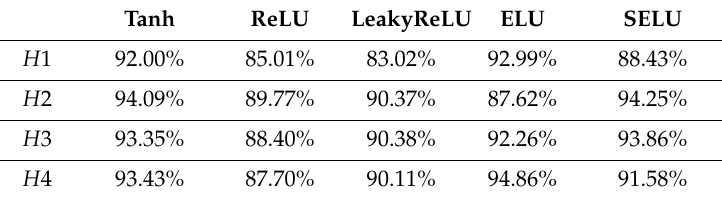
Table 5. The AUC results of the RMSProp